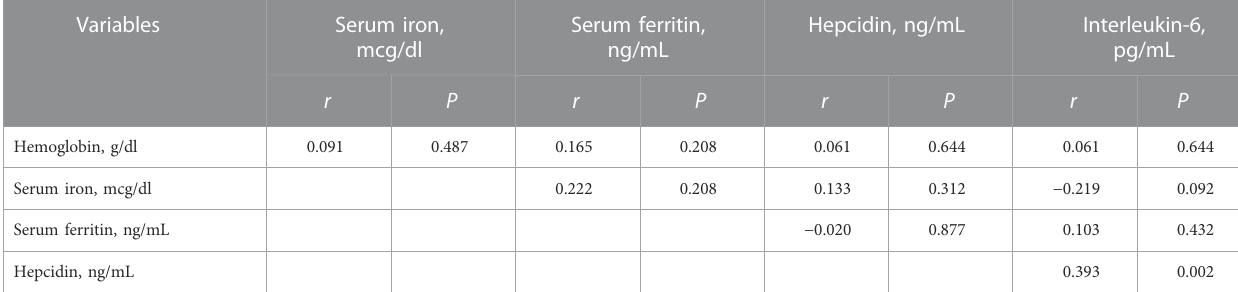
TABLE 3 Spearman correlation between the iron status, hepcidin, and interleukin-6 in pregnant women with preeclampsia in Khartoum Sudan, 2020. Variables Serum iron, Serum ferritin, mcg/dl ng/mL